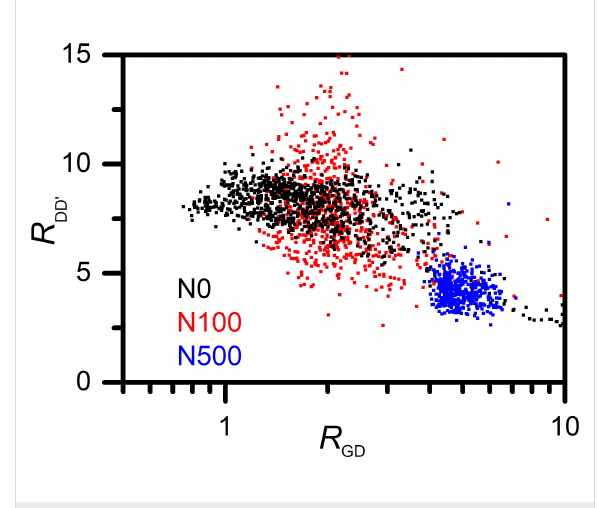
Figure 8: R DD’ ratio dependence on R GD for graphene on NWs with different variations in